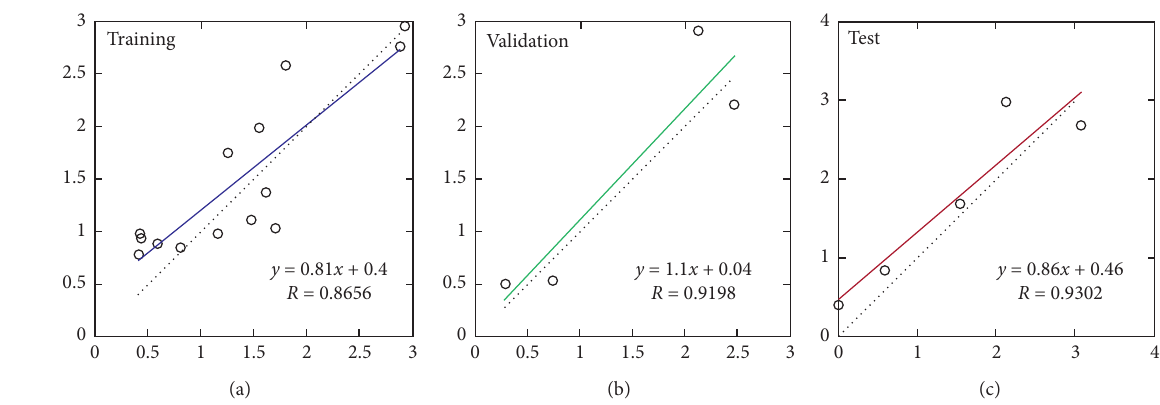
Figure 2: The training, the validation, and the testing data set for the ANN training.